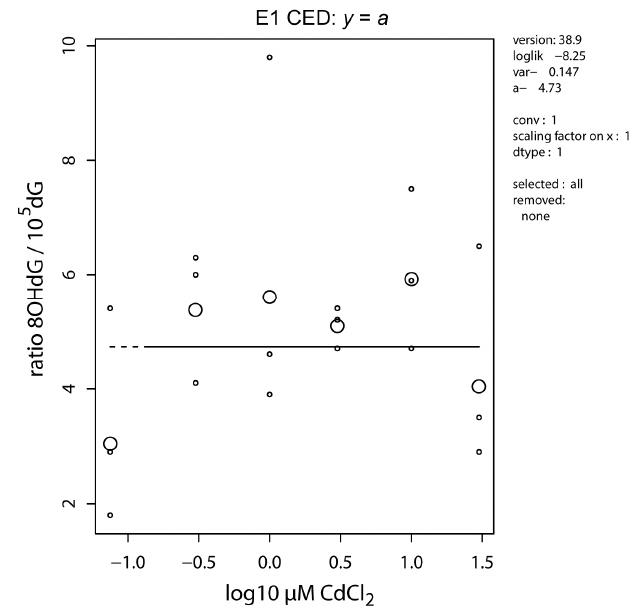
Figure 2. Dose response of the ratio of 8-OHdG/10 5 dG as a measure of DNA oxidation. Small dots are individual observations (pools of 40 embryos), large circles represent median values per concentration ( n = 3).